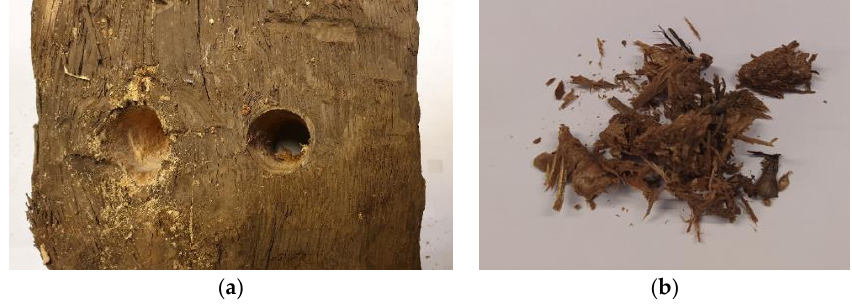
Figure 2. Drilling ( a ) and the obtained raw material sample ( b ).